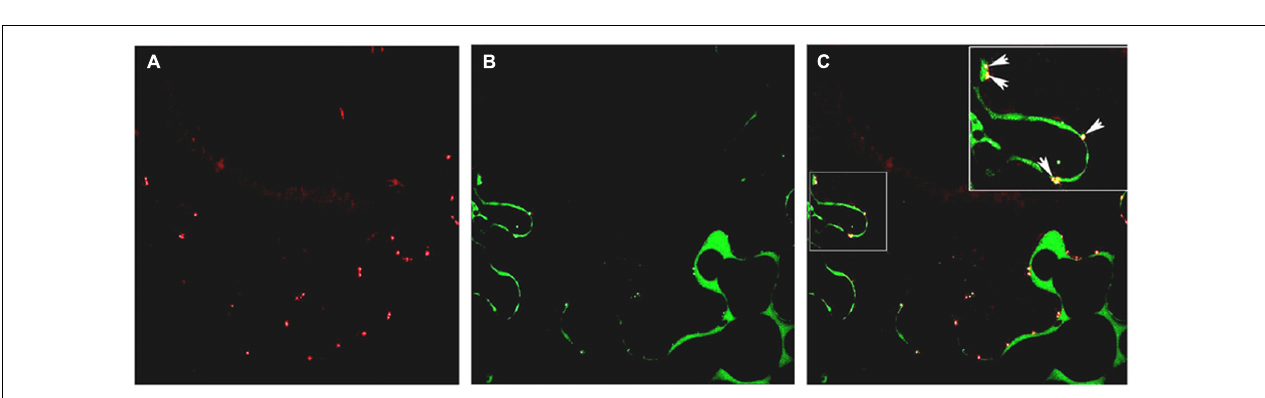
FIGURE 1 | Deletion analysis of the PsEND1 promoter. (A) Promoter regions used in the different constructs (C1–C7). The regulatory motifs related to the specific expression in anthers, GTGANTG10 and Pollen1lellat2, are highlighted in green and blue, respectively. CARG-like motifs are highlighted in pink and purple. (B) GUS staining of Arabidopsis thaliana flowers carrying the construct C4. (C) Gus staining of A. thaliana flowers carrying the construct C5. (D) Gus staining of A. thaliana flowers carrying the construct C7.